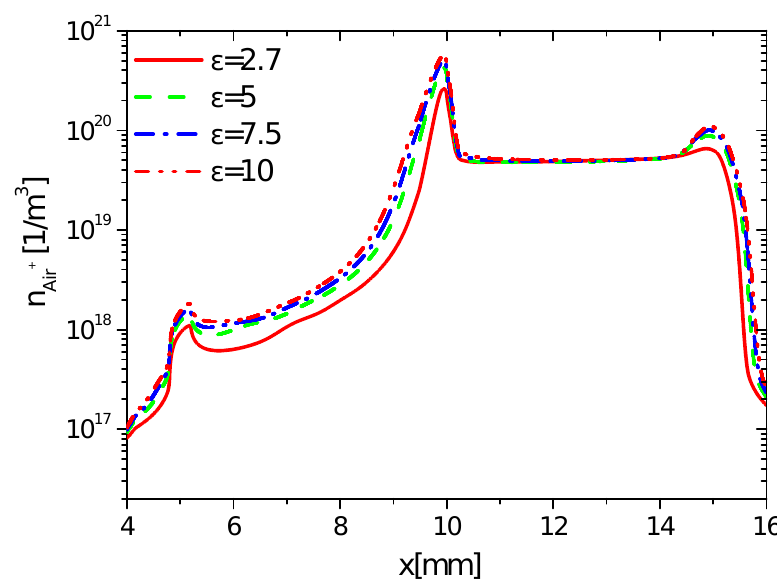
Figure 14. Effect of ε on the distributions of n Air + at 35 ns in the fall phase.